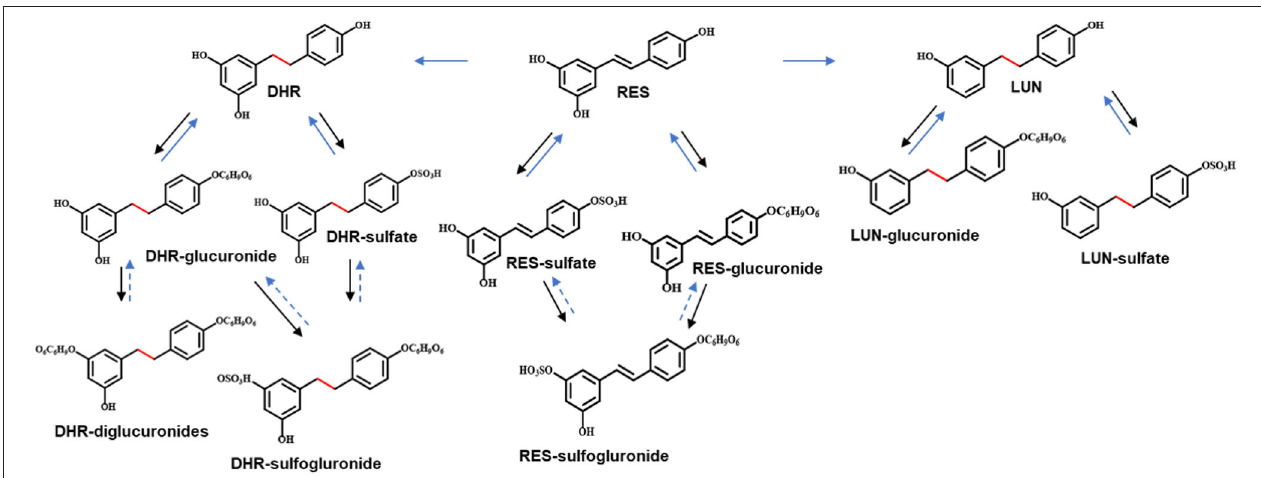
FIGURE 5 | Proposed metabolic pathway of RES. Solid arrows in black indicated metabolism conducted by digestive enzymes. Solid arrows in blue indicated the involvement of gut microbiota. Arrows in dashed lines represented speculated metabolic paths.